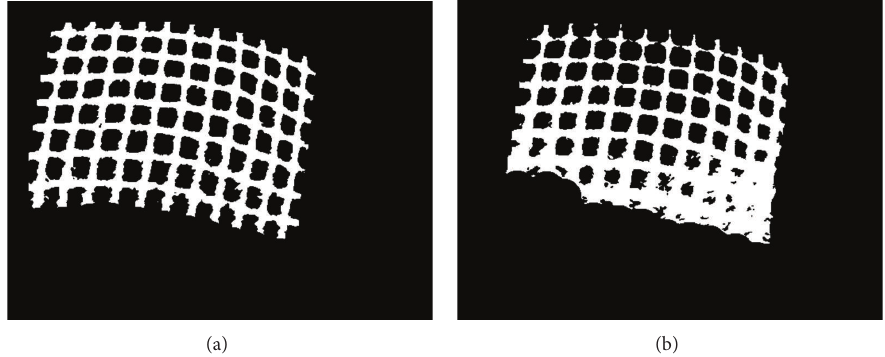
Figure 6: Binary image by thresholding (a) with intensity correction and (b) without intensity correction.